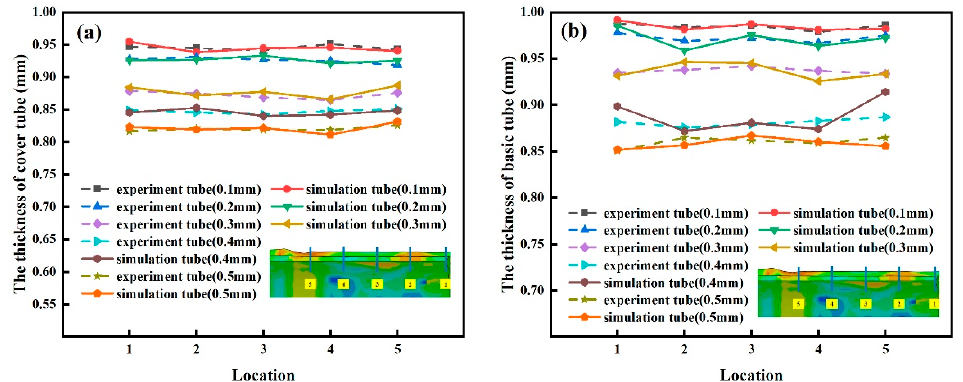
Figure 5. Simulated and experimental results of thickness after rotary ring spinning with different press amounts: ( a ) cover tube; ( b ) basic tube.